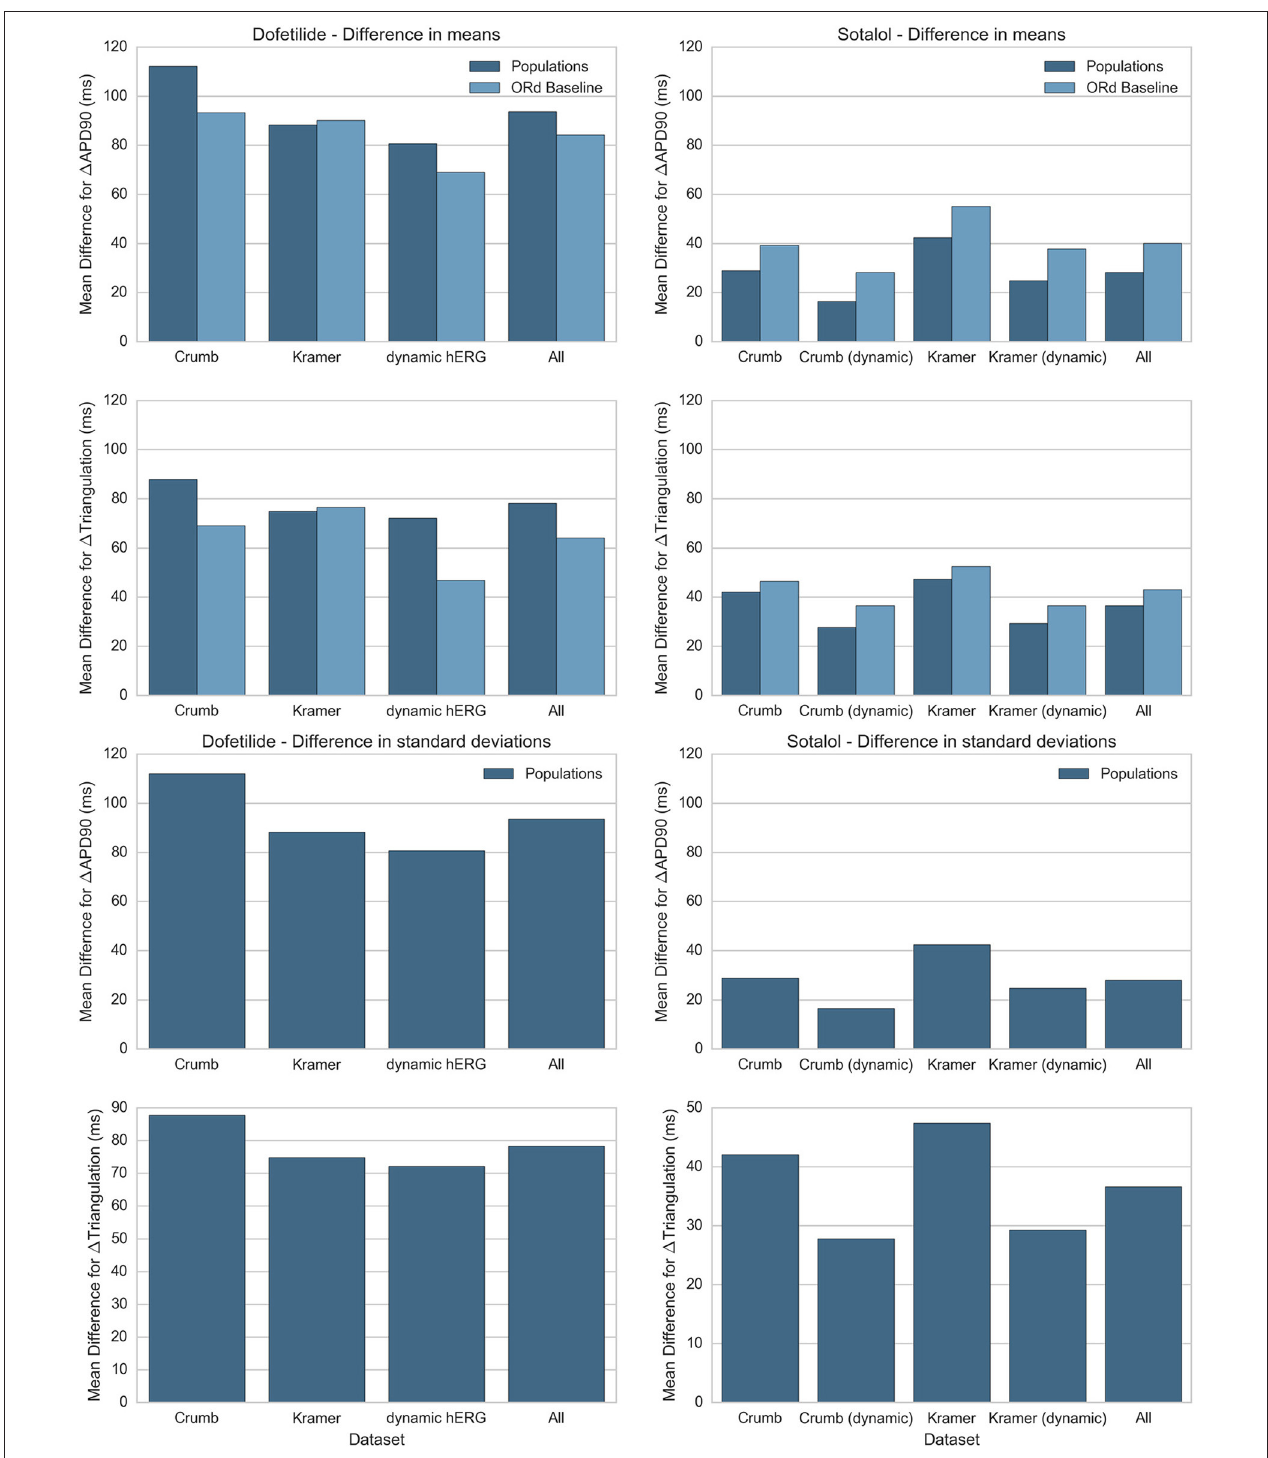
FIGURE 9 | Summary of average difference in mean and standard deviation between experiment and simulation for 1 APD90 and 1 Triangulation. Absolute differences in mean (top) and standard deviation (bottom) between experiments and simulations for 1 APD90 and 1 Triangulation are shown for dofetilide (left) and sotalol (right) , for each drug block dataset. Differences in mean are shown for both the mean of the populations of models (dark blue) and the single biomarker value produced by the ORd baseline model (light blue), while differences in standard deviation can only be shown for the populations of models. Values for each drug block dataset are averaged across all concentrations and frequencies used in this study. Results for dofetilide show only one block dataset for the dynamic hERG model as neither Crumb nor Kramer IC50 datasets contained non-hERG IC50s for dofetilide (for sotalol, Kramer et al. measured an IC50 for Cav 1.2).